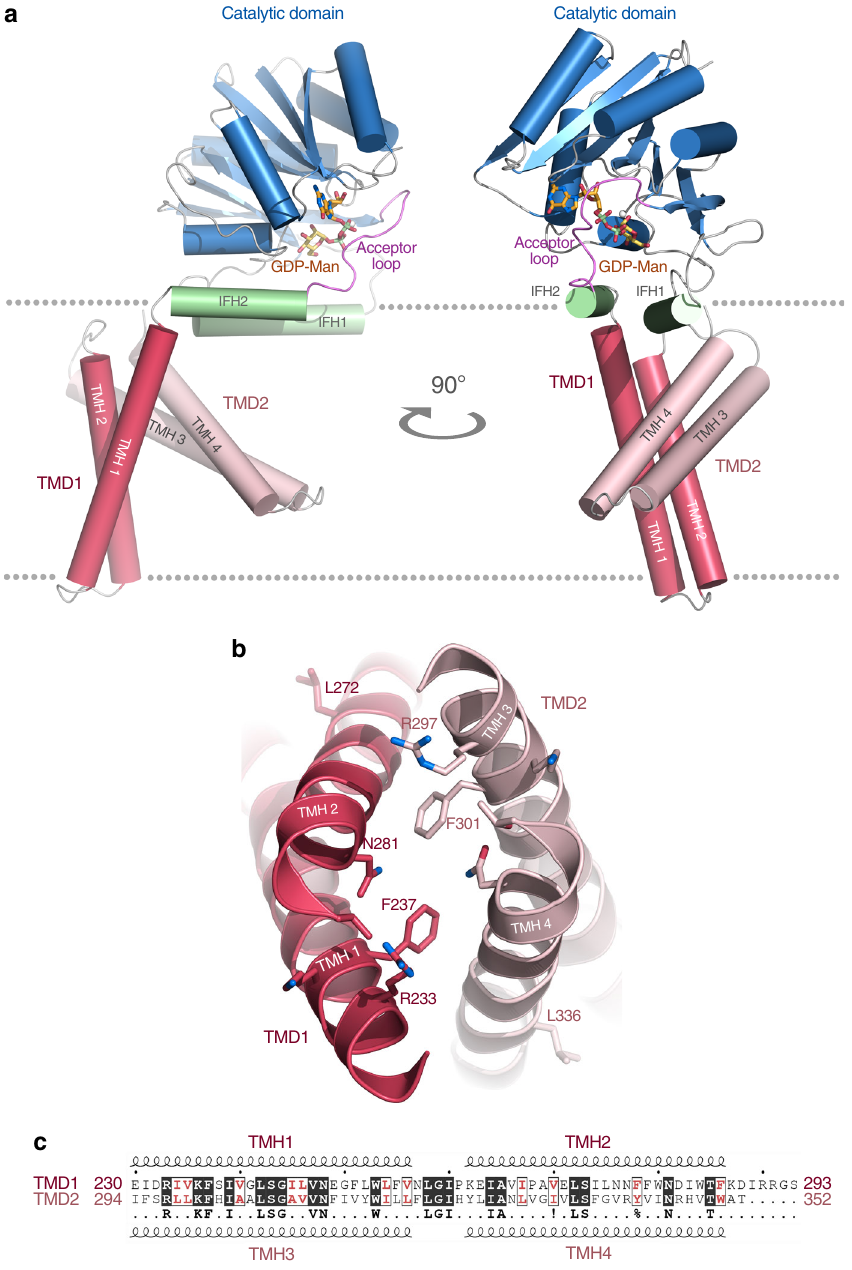
Fig. 1 Overall structure of Pf DPMS. a Structure of Pf DPMS with bound GDP-Man and Mn 2+ . The acceptor loop ( purple ) is locked in a closed conformation. b Two-fold pseudo symmetry of the TMD1/TMD2 interface. c Sequence similarity between TMD1 and TMD2, including the residues that de fi ne the pseudo twofold symmetry in